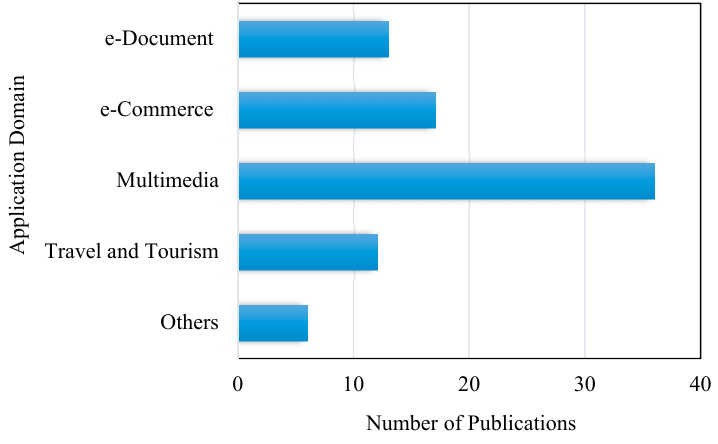
Figure 5. Classification by Domain of Applications. Table 4. Application Domain and the Concept Drifts